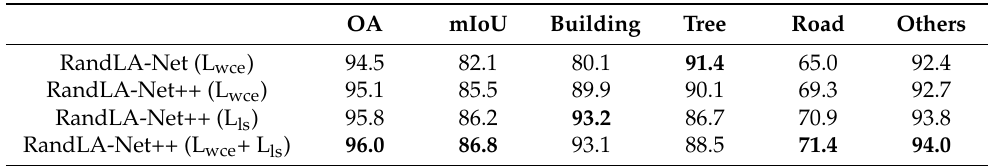
Table 5. Segmentation results evaluated on IoU of each category, mIoU, and OA of the NJSeg-3D dataset. Whether to add dilated convolution and different loss functions, respectively. Note: the bold numbers represent the highest score in each column. OA mIoU Tree Road